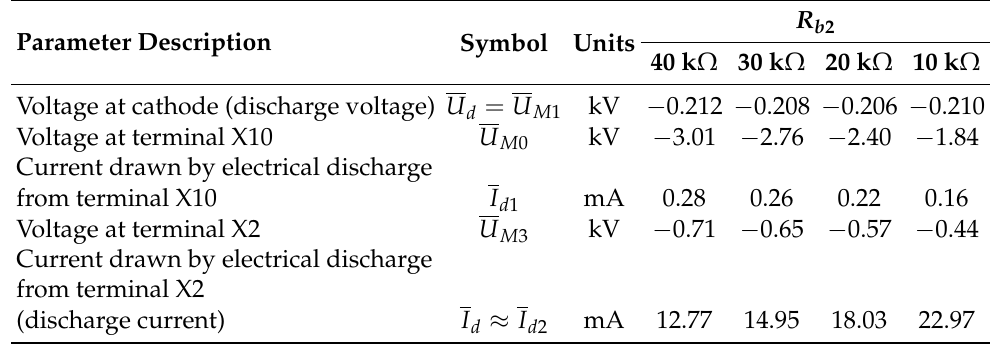
Table 2. Averaged electrical parameters of the electric supply circuit during the normal operation regime for U i = 400 V rms and different ballast resistance R b 2 .